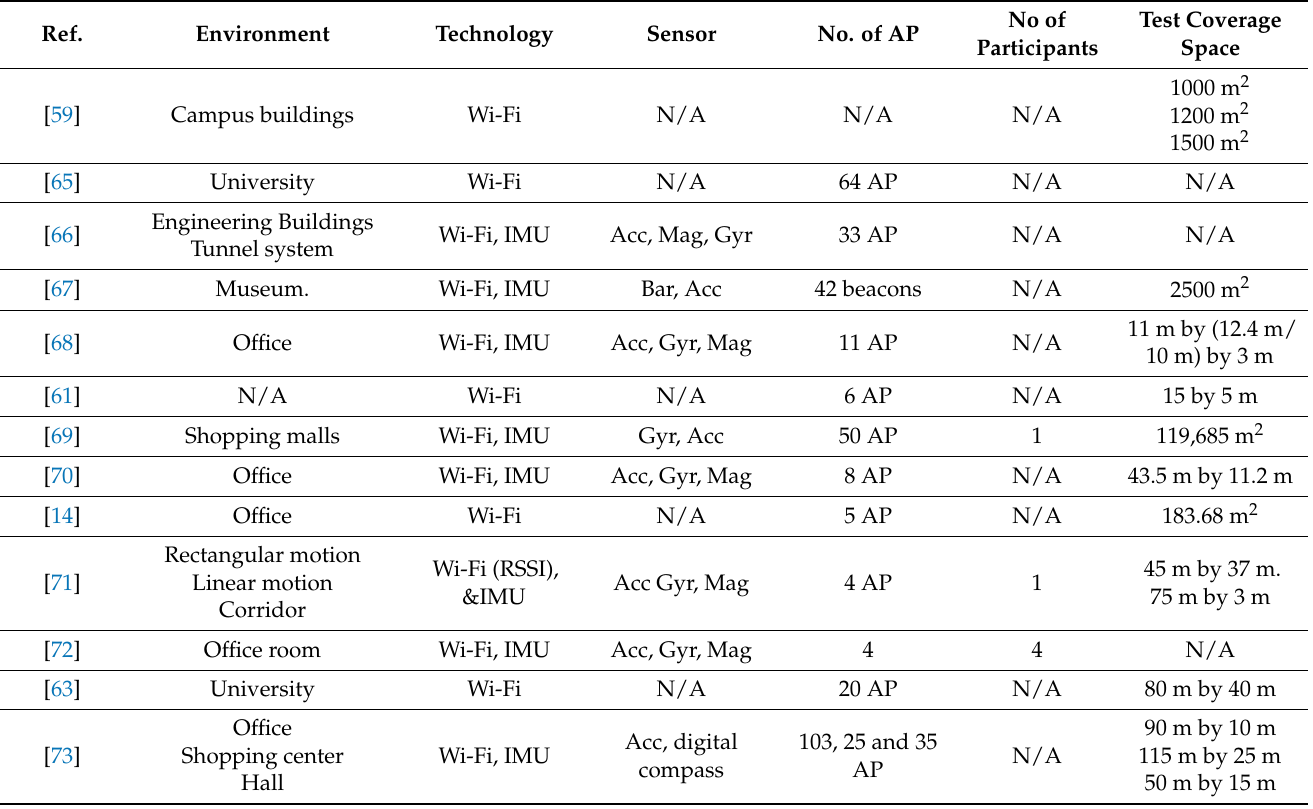
Table 4. The characteristics of indoor localization data